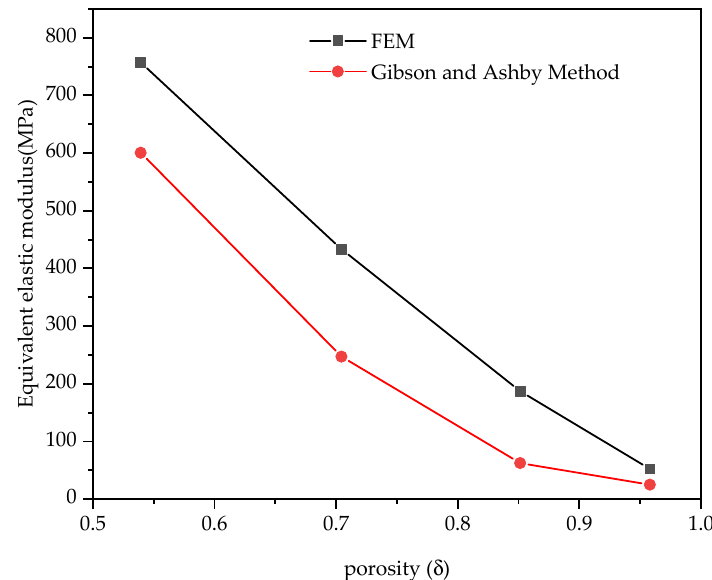
Figure 10. Comparison of the equivalent elastic moduli of the two methods for all models.